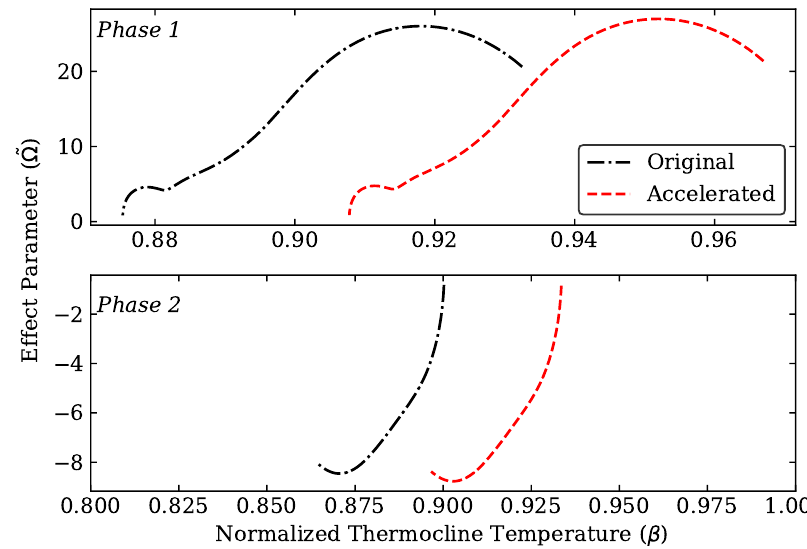
Figure 16. Scaled process curves of discharging mode at the inlet location.